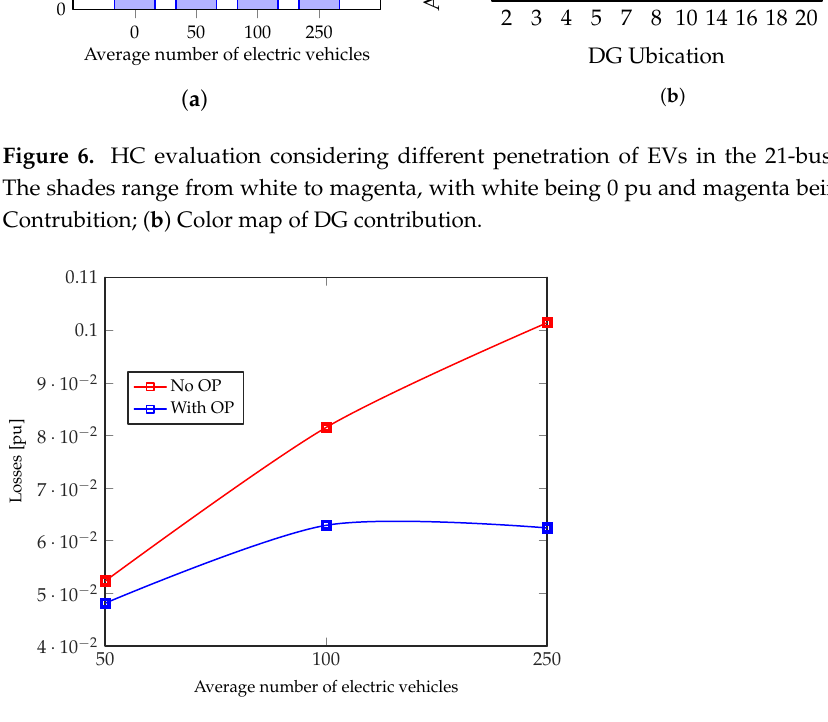
Figure 7. Loss behavior considering optimal HC management in a 21-bus DC